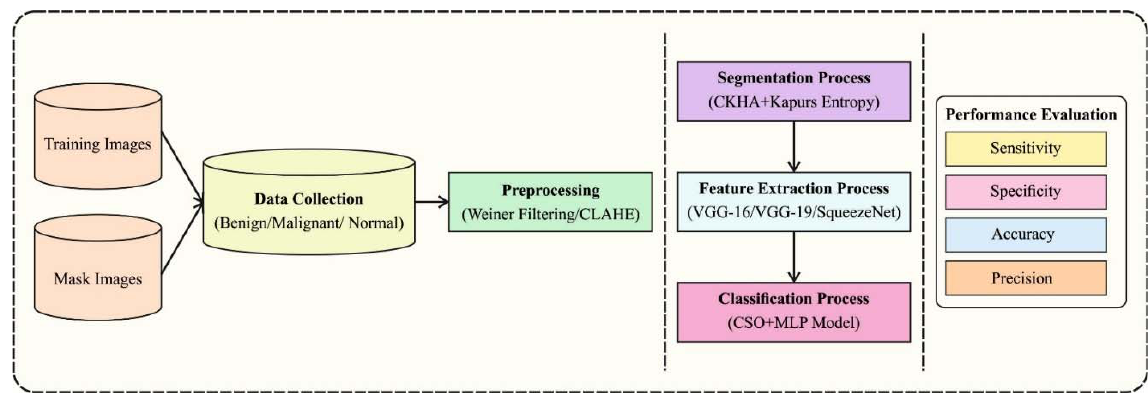
Figure 1. Overall process of the EDLCDS ‐ BCDC technique.